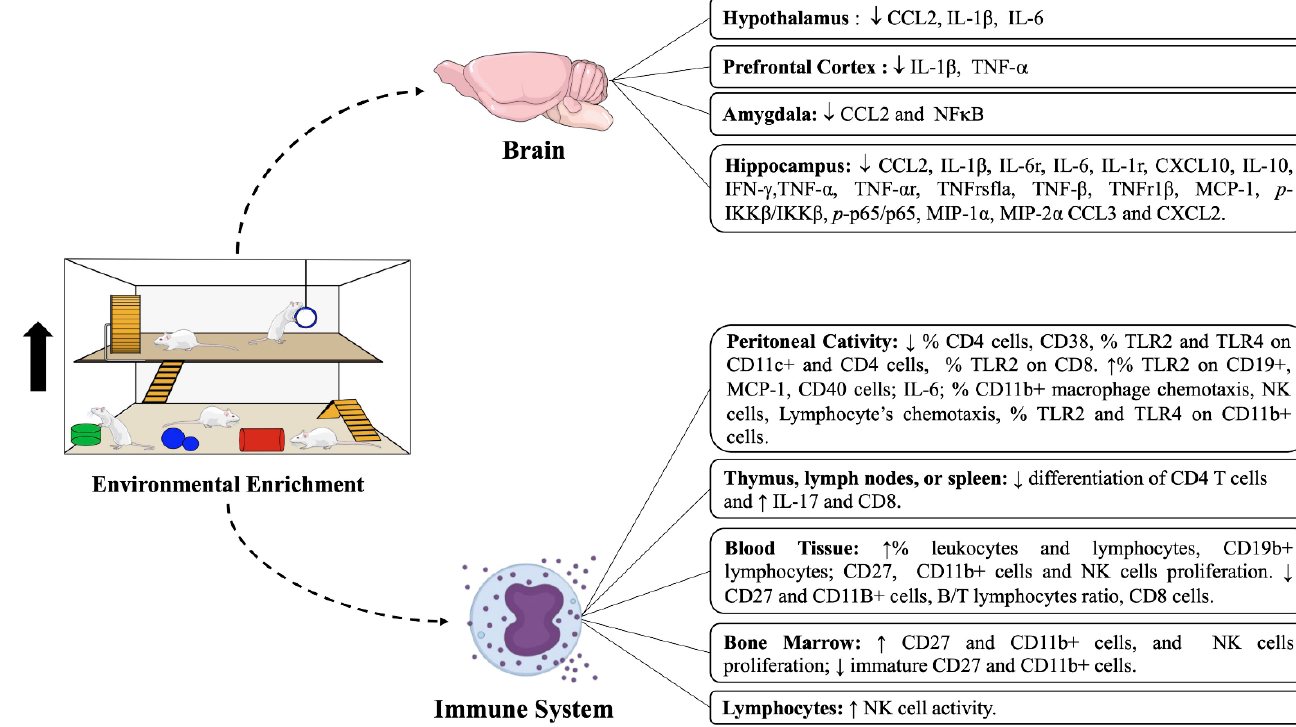
Figure 2. Impacts of environmental enrichment protocols on the activity of different cells of the immune system and expression of pro and anti-inflammatory cytokines in central (Hypothalamus, Prefrontal Cortex, Amygdala, and Hippocampus) and peripheral tissues (Peritoneal cavity, Thymus, Lymph nodes, Spleen, Blood Tissue, or Bone Marrow) and Lymphocytes.